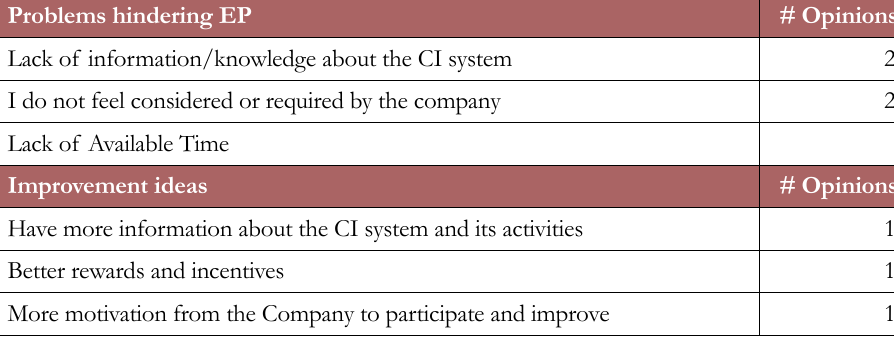
Table 1. Industrial case: Top 3 improvement ideas and problems hindering EP